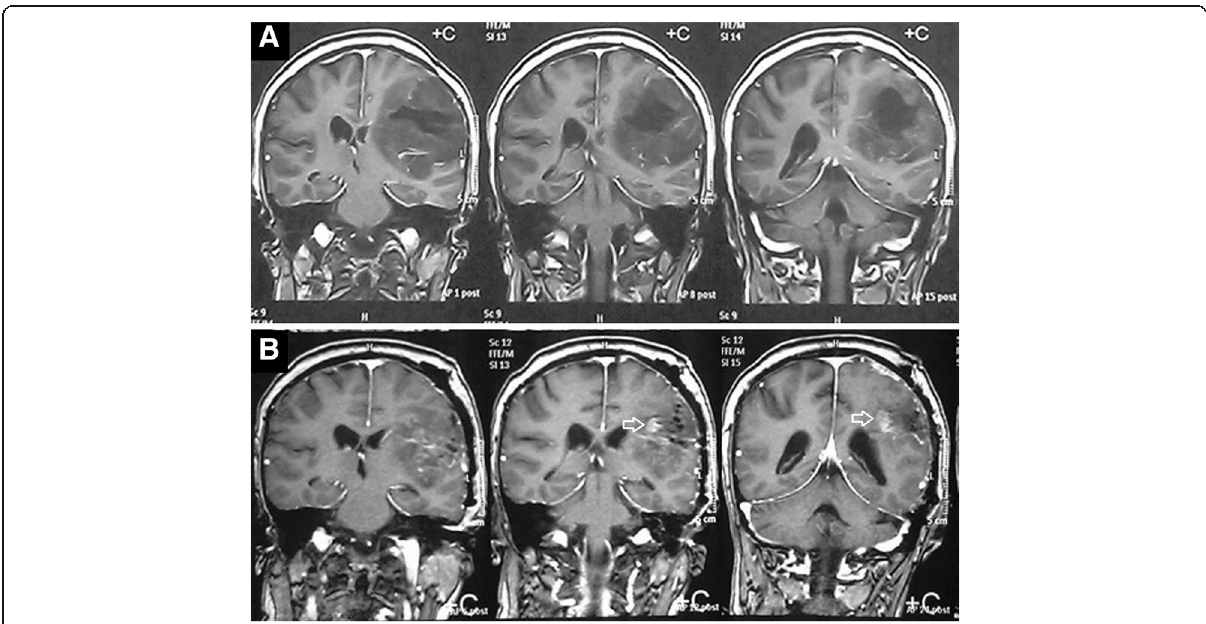
Fig. 6 a MRI brain, coronal cuts with contrast showing a Lt. temporoparietal recurrent/residual grade III astrocytoma. b Postoperative MRI brain, coronal cuts with contrast showing near total resection of the lesion with a very small enhancing residual (white